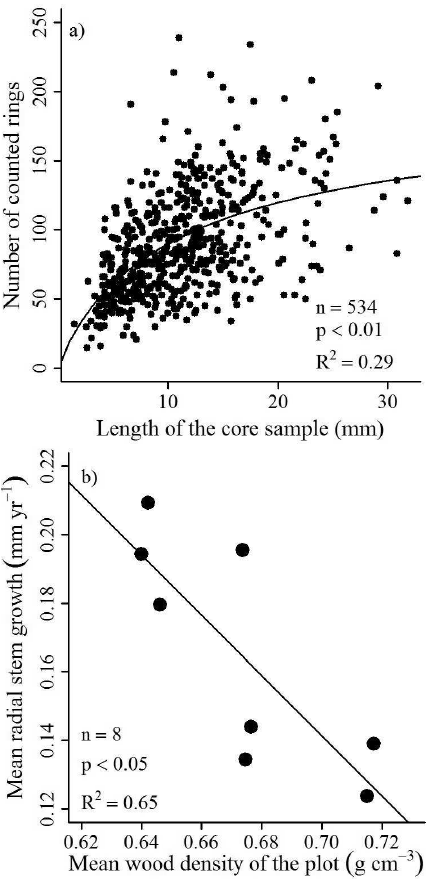
Fig. 4. (a) Significant non-linear relationship between the number of counted rings and length of the core samples for all analyzed trees with distinct growth rings and (b) significant correlation between estimated mean radial stem growth and mean wood density of the eight 1ha